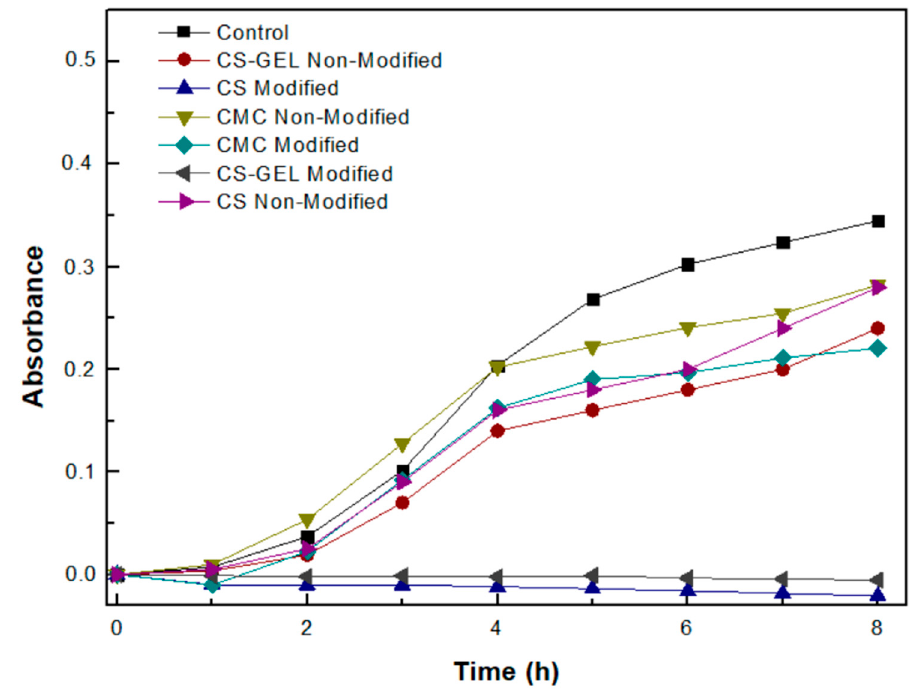
Figure 11. Growth curve of bacterial populations of strain BL21DE3 after 12 h of incubation in the presence of a certain amount of enzymatically modified and non-modified biopolymer membranes as a function of time. (The standard deviation was less than 5% in all cases.)